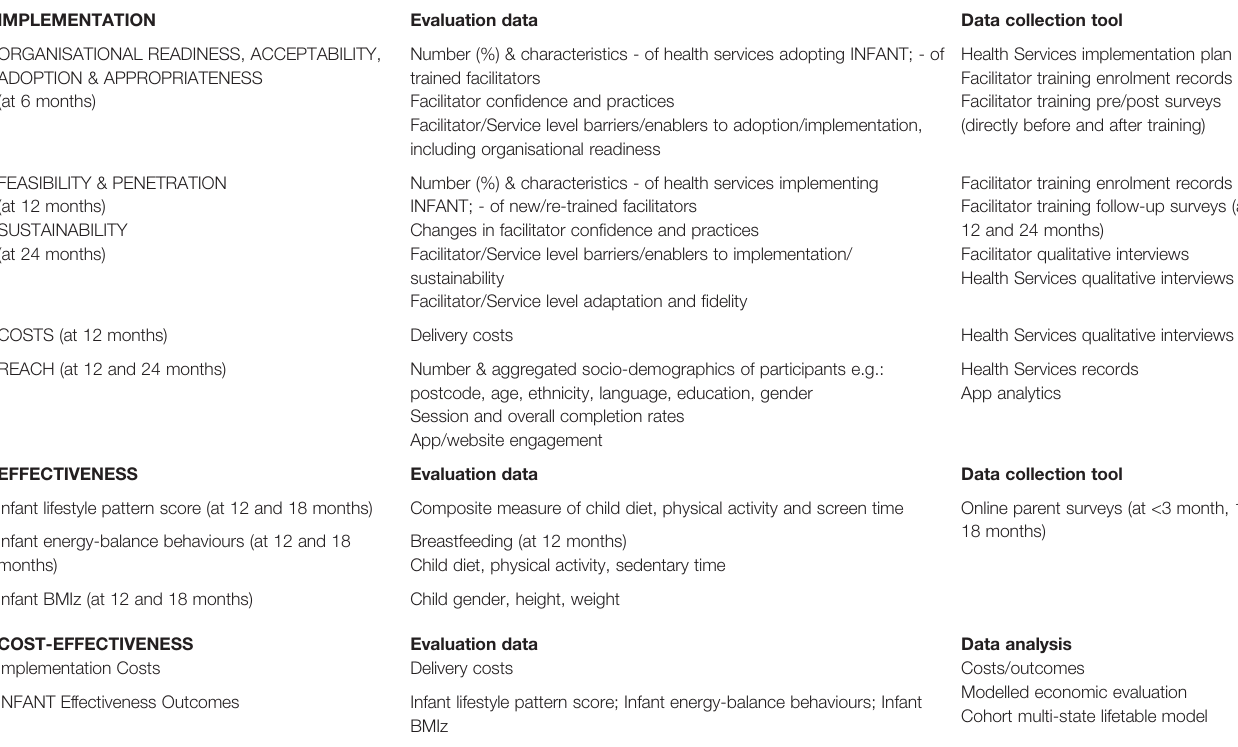
TABLE 2 | Implementation-effectiveness trial